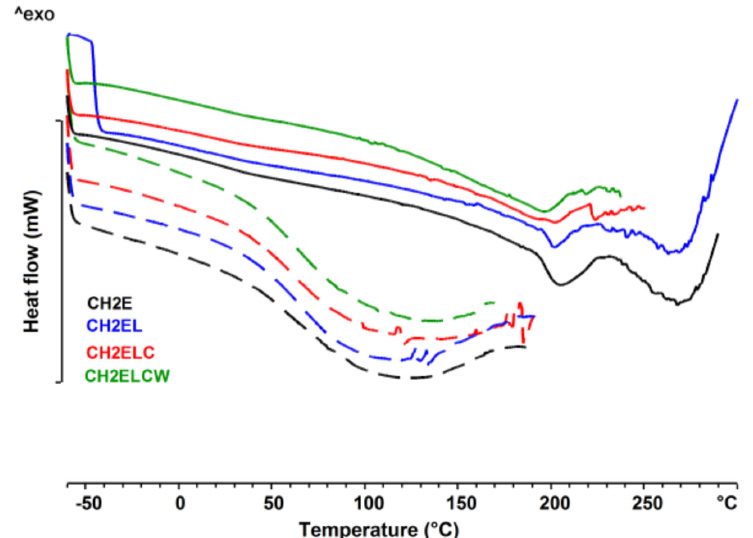
Figure 14. DSC curves of chitosan/starch − based samples; 1st heating (dotted line) and 2nd heating (solid